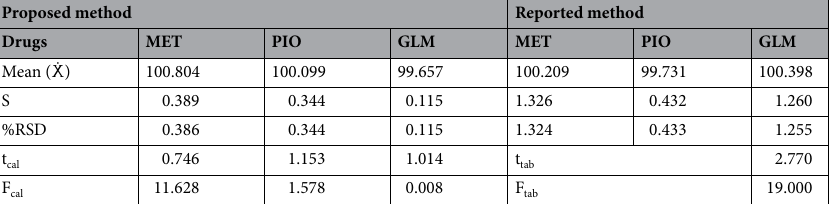
Drug MET PIO GLM Concentration range